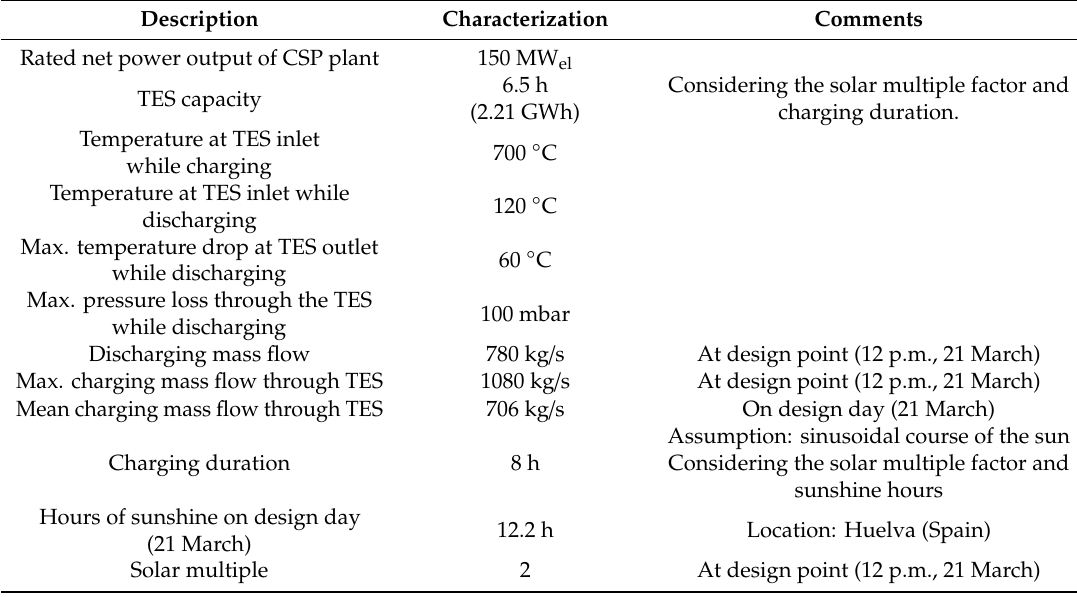
Table 1. Concentrated solar power (CSP) plant specifications.